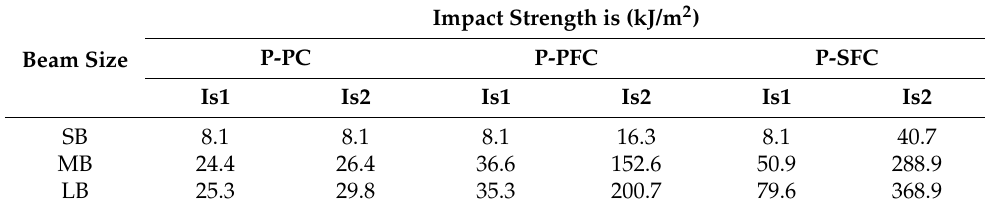
Table 4. Impact strength of the tested beam